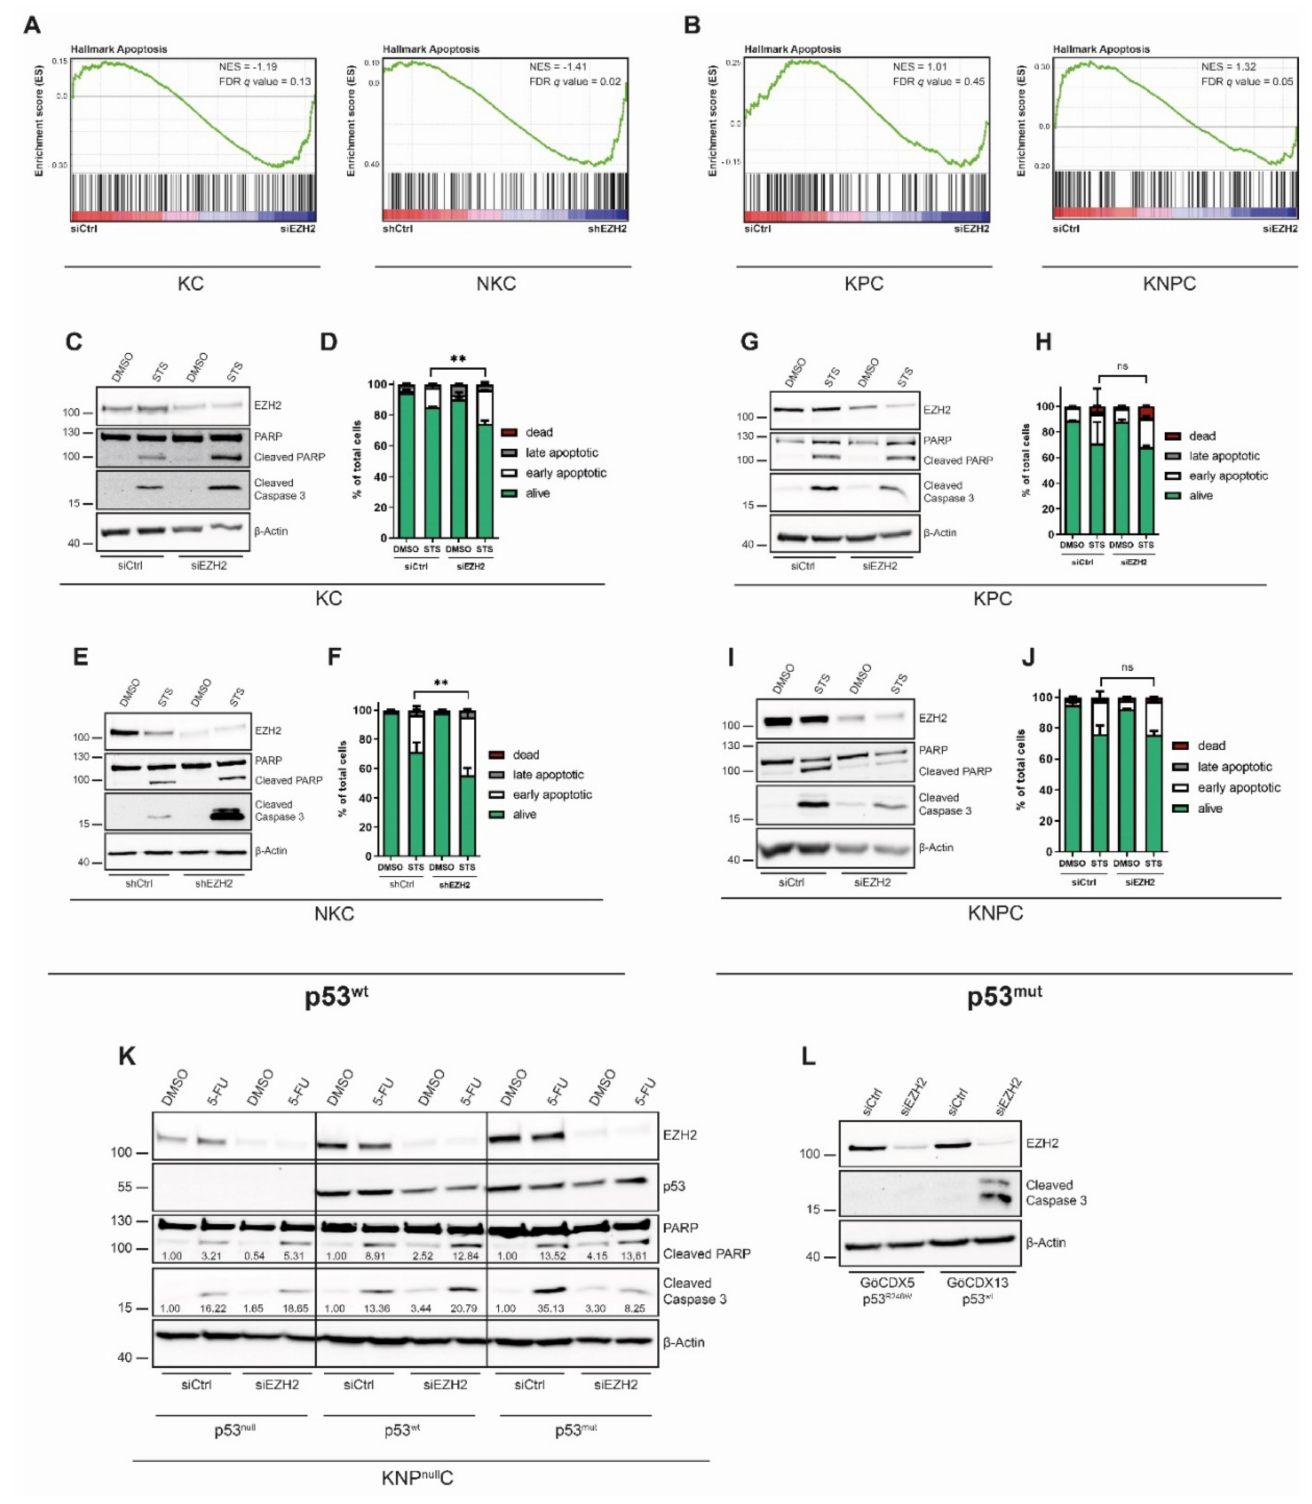
Figure 3. Inverse effects of apoptotic processes depending on the Trp53 -status. ( A , B ) GSEA plot in the indicated p53wt ( A ) and p53mut ( B ) PDAC cells comparing the enrichment of apoptosis- related genes upon knockdown of EZH2 after RNA-seq. NES and FDR as indicated on the graph. ( C – J ) Depletion of EZH2 in PDAC cells with p53wt (KC, NKC) and p53mut (KPC, KNPC) expression and simultaneous treatment with staurosporine (STS). Western blot analysis of apoptosis-related pro- teins ( C , E , G , I ) and Annexin-V/propidium iodide staining and subsequent FACS analysis (( D , F , H , J ),